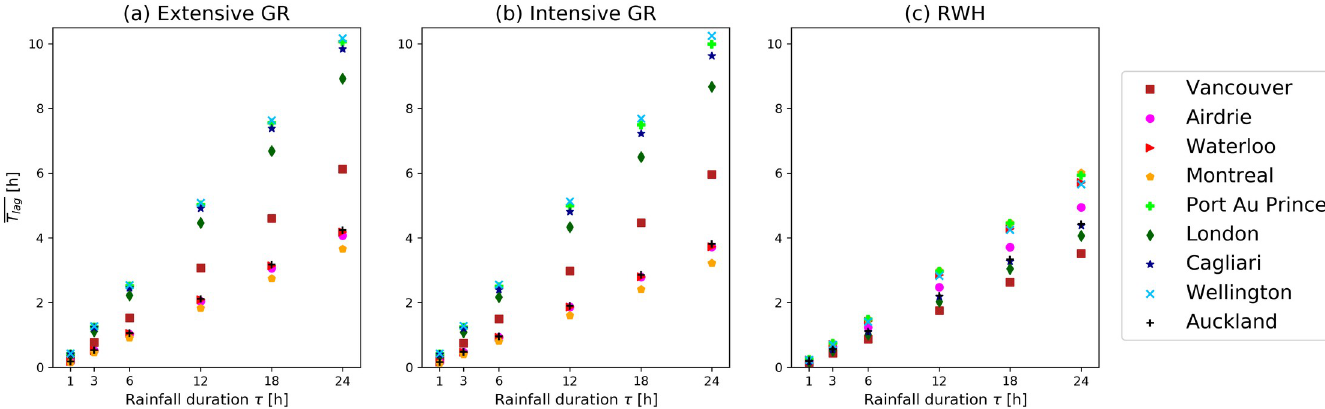
� . Six potential rainfall durations corresponding to 1, 3, 6, 12,18 and 24 h have been investigated and plotted for lag